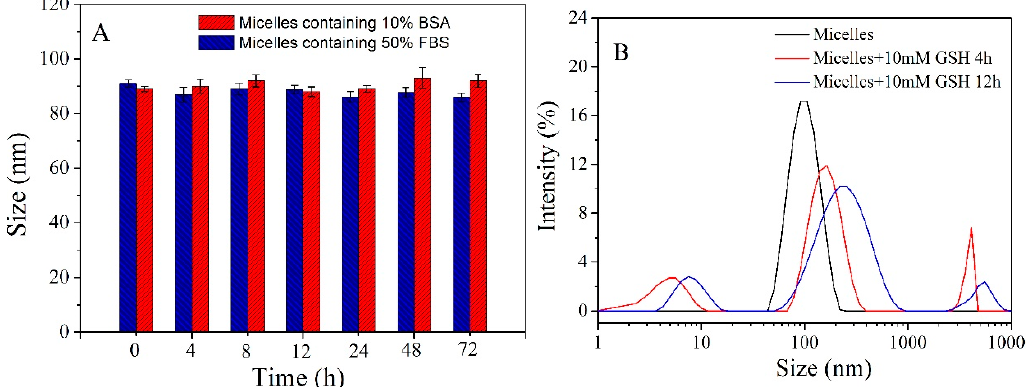
Figure 3. The size of micelle incubation with PB (50 mM, pH 7.4) containing 10% BSA and 50% FBS